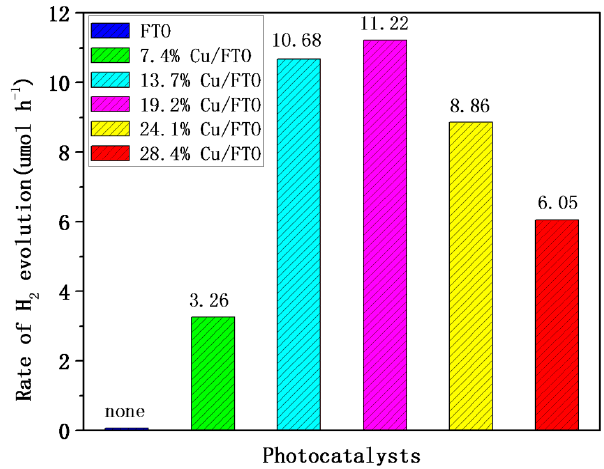
Figure 10. Photocatalytic H 2 evolution rate of FTO (Sn/F = 10/5) and Cu/FTO (Sn/F = 10/5) with different contents of Cu.